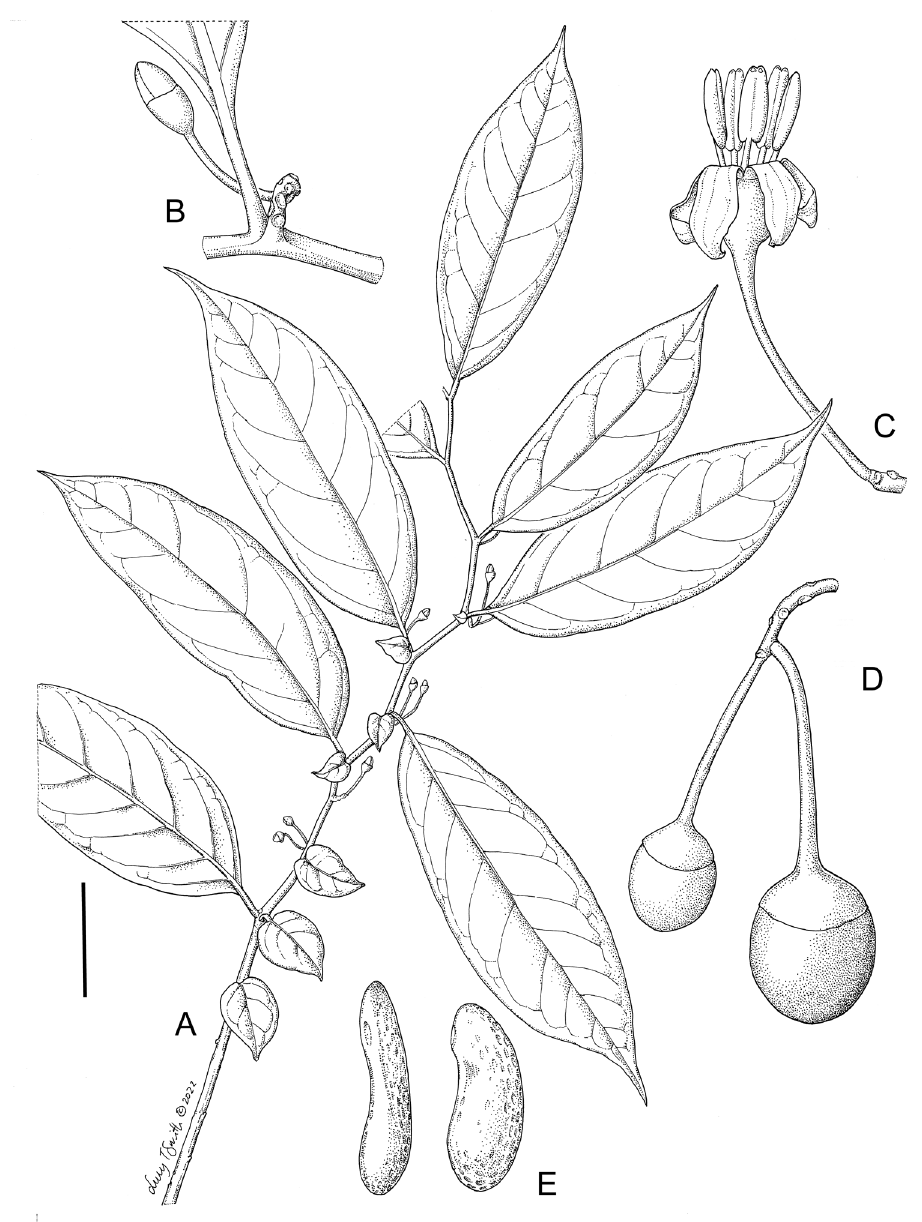
Figure 22. Lycianthes impar (Warb.) Bitter A flowering branch B inflorescence with bud C short-styled flower D berries E seeds. ( A Utteridge et al. 119 , B van Leeuwen 11108 , C Sands 7329 , D, E Puradyatmika et al. 10428 ). Drawing by Lucy Smith. Scale bars: 4 cm ( A ); 5 mm ( B, C ); 0.75 cm ( D ); 1.4 mm ( E